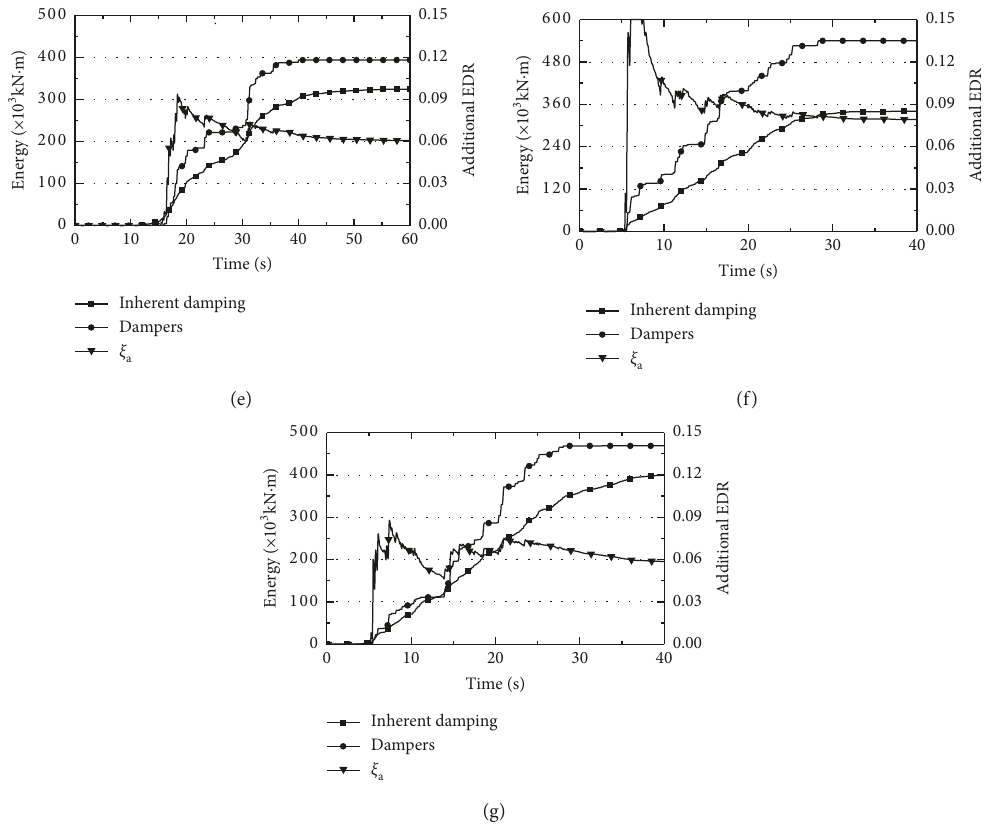
Figure 7: Cumulative energy dissipated by inherent damping and MYDs and time histories of additional EDR (the lines of inherent damping and the damper denote the cumulative energy dissipated by inherent damping and damper, respectively): (a) NW1; (b) NW2;